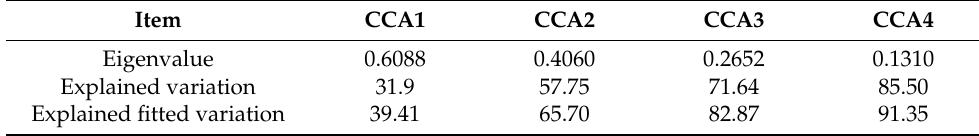
Table A4. The result of